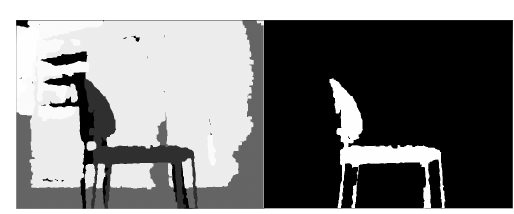
Figure 5. Comparison with binarized